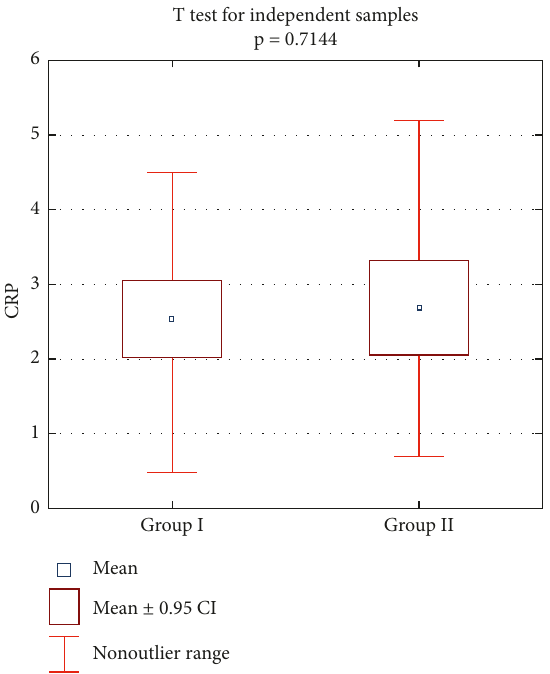
Figure 2: Average C-reactive protein values, obtained in both groups, presented in statistical evaluation.